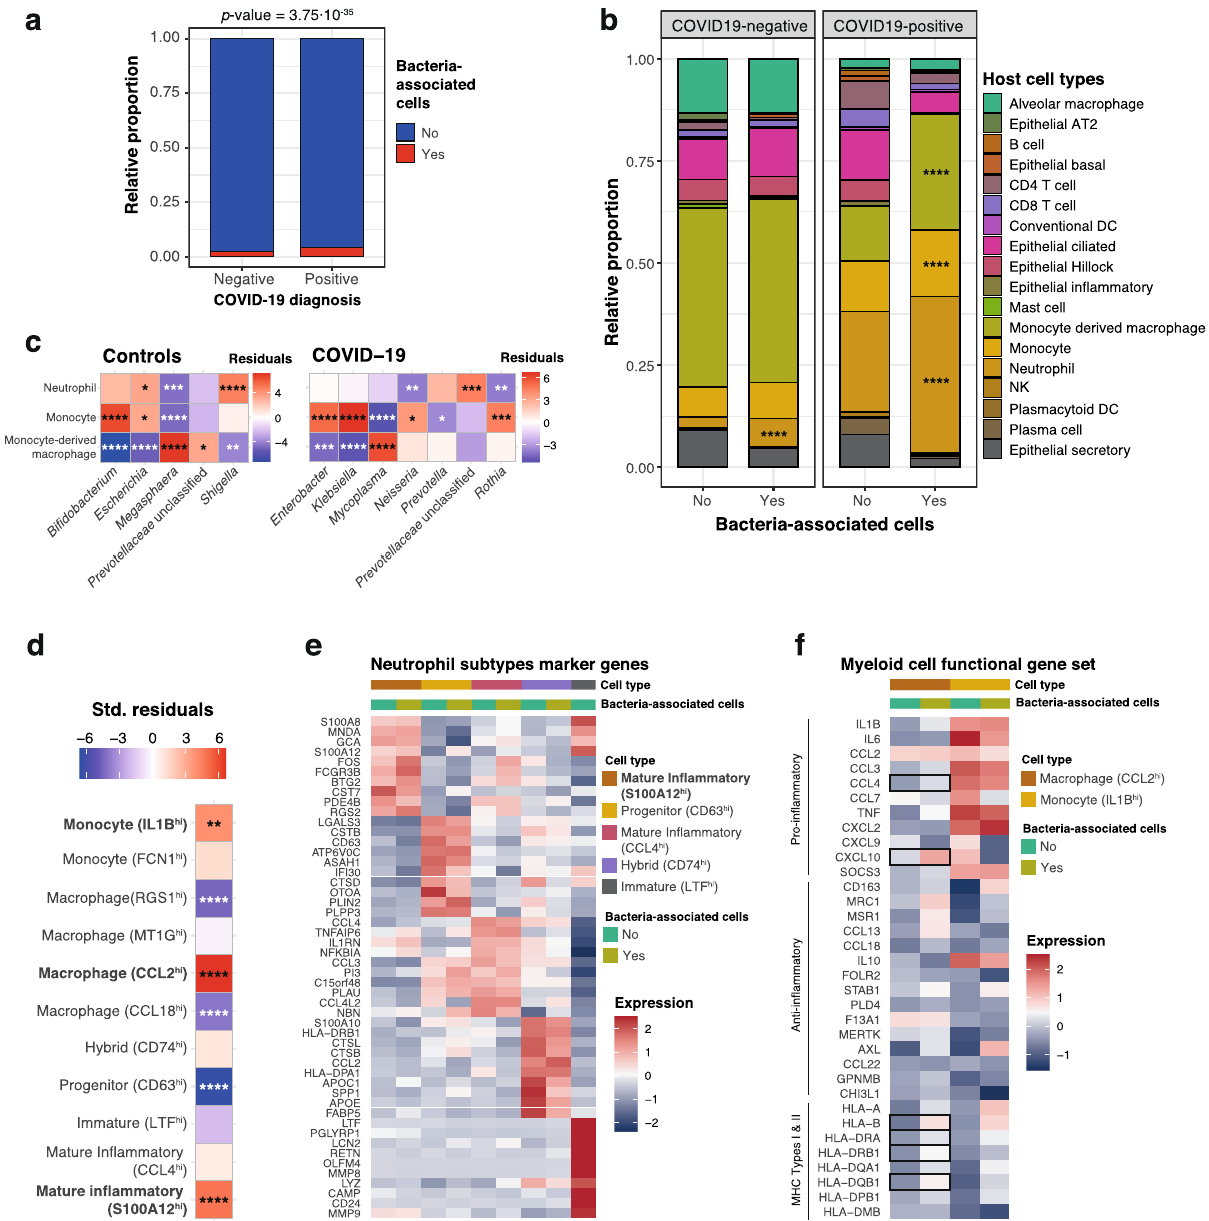
Fig. 3 Host single cells associated to the lower respiratory tract microbiota. a relative proportion of cells from negative ( n = 31,923 cells) and positive ( n = 33,243 cells) COVID-19 patients with (red) and without (blue) associated bacteria. The p value of a two-tailed Chi-squared test using the count data is shown on top. b Cell types enriched in bacteria-associated cells. Barplots represent the proportion of cell types without ( “ No ” ; n = 63,463 cells) and with ( “ Yes ” ; n = 1,703 cells with 2108 bacteria detected) bacteria in COVID-19 positive and negative patients. For each patient class, we tested for enrichment of bacteria-associated cells ( “ Yes ” ) across the different cell types, using the proportions of non-bacteria associated cells ( “ No ” ) as background (Chi- squared tests, two-tailed). c Bacterial genera preferentially associating to speci fi c cell types. The heatmaps show the standardized residuals of a two-tailed Chi-squared test including all bacterial genera and the three host cell types enriched in bacteria, for controls (left) and COVID-19 positive patients (right). Taxa with no signi fi cant associations with any of the cell types are not shown. Enrichments are shown in red; depletions are depicted in blue. d Host cell subtypes associated with bacteria. The heatmap shows the standardized residuals of a two-tailed Chi-squared test, including the subtypes of neutrophils, monocytes and monocyte-derived macrophages with associated bacteria, considering cells without bacteria as background. Enrichments are shown in red; depletions are depicted in blue. e Marker genes detected for the 5 different subtypes of neutrophils, showing within-group differences between bacteria- associated and bacteria-non-associated cells. f Myeloid cell functional gene set showing the expression of canonical proin fl ammatory, anti-in fl ammatory and MHC-encoded genes for the two subtypes of myeloid cells signi fi cantly associated with bacteria (CCL2 hi -macrophages and IL1B hi -monocytes). The heatmap also shows within group differences between bacteria-associated and non-associated cells. Statistically signi fi cant differences (two-sided Wilcoxon rank-sum test, Bonferroni-adjusted p value < 0.05) are marked with squares. For ( b – d ) asterisks denote signi fi cance after BH multiple testing correction as follows: * p value ≤ 0.05; ** p value ≤ 0.01; *** p value ≤ 0.001; **** p value ≤ 0.0001; exact p values are provided in Supplementary Data 3. Source data are provided as a Source Data fi le.